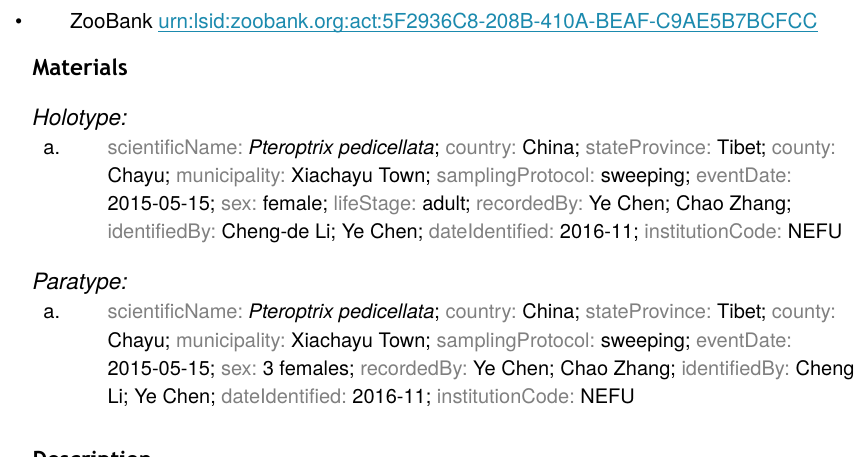
Female. Holotype. Body length 0.51 mm. Head dark brown, eyes black. Antenna mostly brown except pedicel and C1 paler. Thorax with pronotum, most part of mid-lobe of mesoscutum and axillae dark brown, side lobes and posterior part of mid-lobe of mesoscutum pale brown, scutellum and propodeum yellowish-white. Scutellum with light blue re fl ection in dorsal view. Wings hyaline, distinctly infuscated below marginal vein of fore wing, venation brown. Legs extensively dark brown, except fore coxae apically, mid coxae completely, apical half of all tibiae and tarsi pallid. Metasoma dark brown with the third valvula pale brown. Head (Fig. 1a), in frontal view, about as long as wide; frontovertex about 0.5× head width. Ocellar triangle with apical angle obtuse. OOL larger than OCL and subequal to OAL. The sculpture and setation on the upper face as in a. Toruli with lower margins separated from mouth margin less than their own longest diameter and distance between toruli about as long as their longest diameter. Mandible tridentate. Antenna (Fig. 1b) with radicle 2.0× as long as wide, scape 4.75× as long as wide; pedicle 1.76× as long as wide and 1.20× as long as F1; F1 1.79× as long as wide, F2 subquadrate and 0.68× as long as F1; C1 2.3× as long as wide, a little longer than the two funicle segments combined; C2 about as long as or somewhat shorter than C1; C3 a